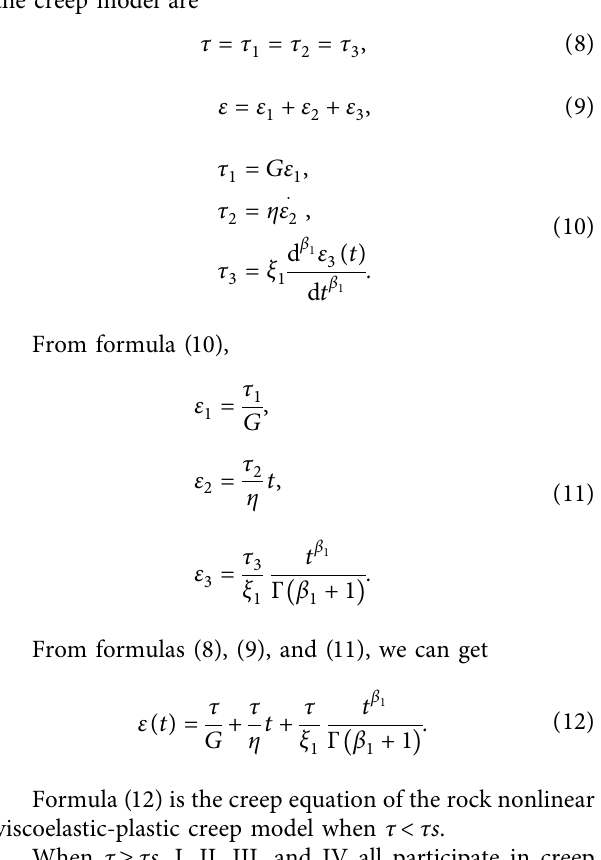
Figure 3: Schematic diagram of the rock nonlinear viscoelastic- plastic creep